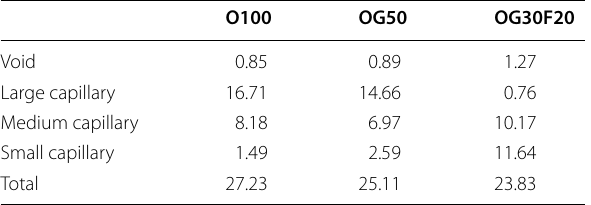
Table 4 Classification of pore sizes in hydrated paste